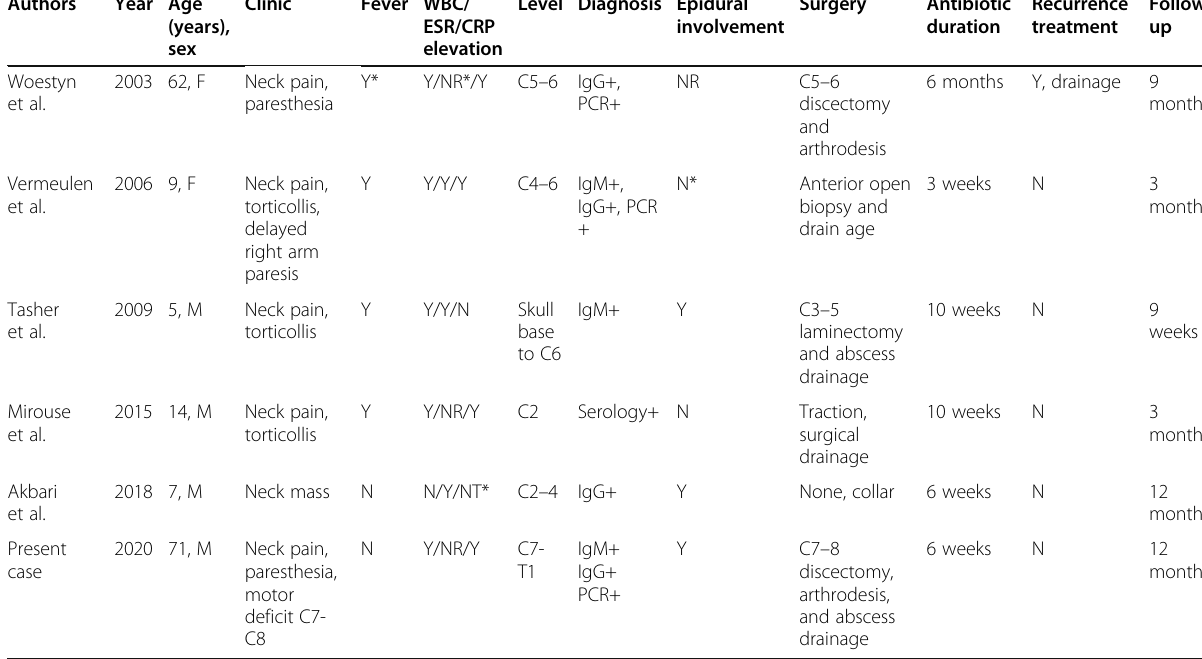
Table 1 Reported cases of cervical spine osteomyelitis secondary to the cat-scratch